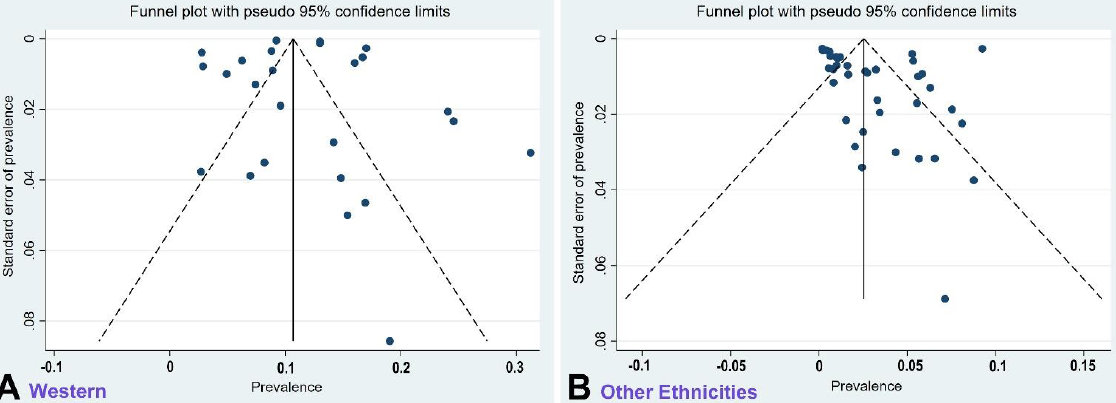
Figure 6. The funnel plots for the Western studies ( A ) and the studies for all other ethnicities ( B ) reporting omicron-induced olfactory dysfunction. These are scatterplots of prevalence levels against their standard errors. The vertical solid line is the estimated effect size; the dotted lines are the cor- responding pseudo 95% confidence intervals (CIs). They provide insight into the spread of observed effect sizes. The majority of studies are randomly scattered within the CI region, indicating absence of publication bias for Western studies (A, p = 0.591) and for all other ethnicities (B, p = 0.703).